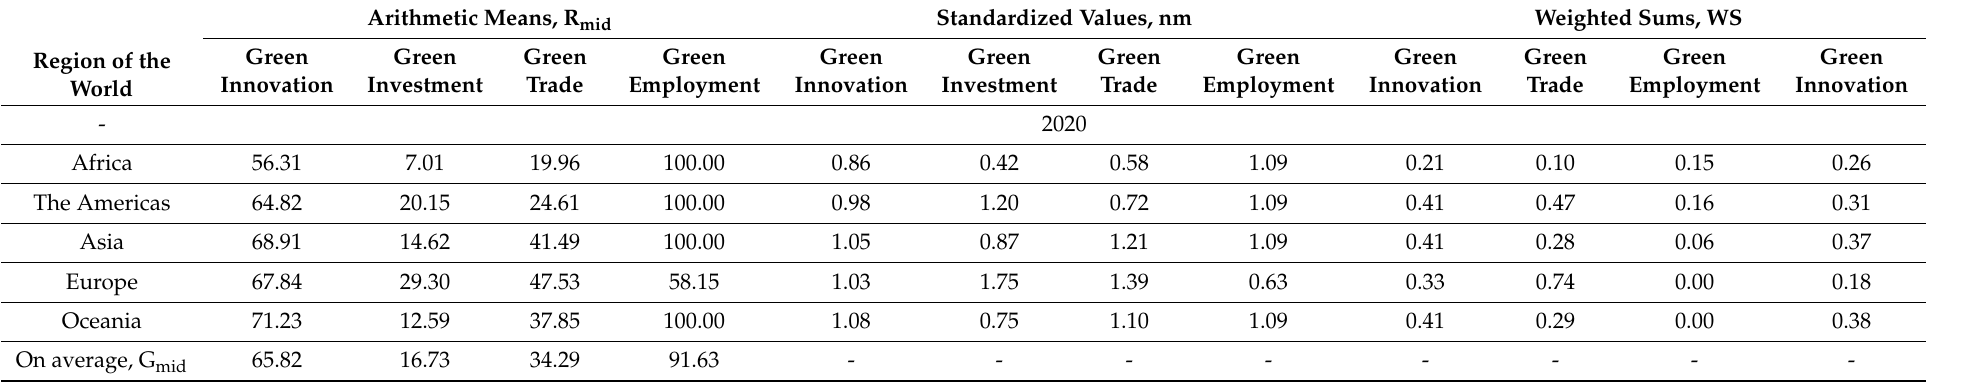
Table 5. Calculation of arithmetic means, standardized values, and weighted sums for the optimisation values. Arithmetic Means, R mid Standardized Values, nm Weighted Sums, WS Green Green Green Green Region of the Innovation Investment Trade Employment World